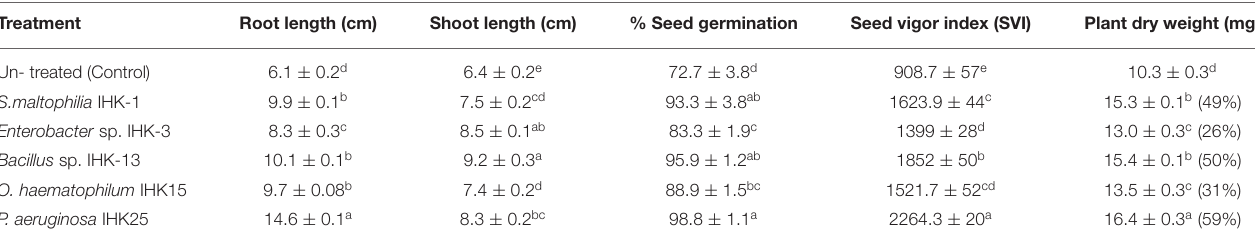
TABLE 6 | Effect of potential PGP diazotrophic bacteria on rice seed germination and plant growth.